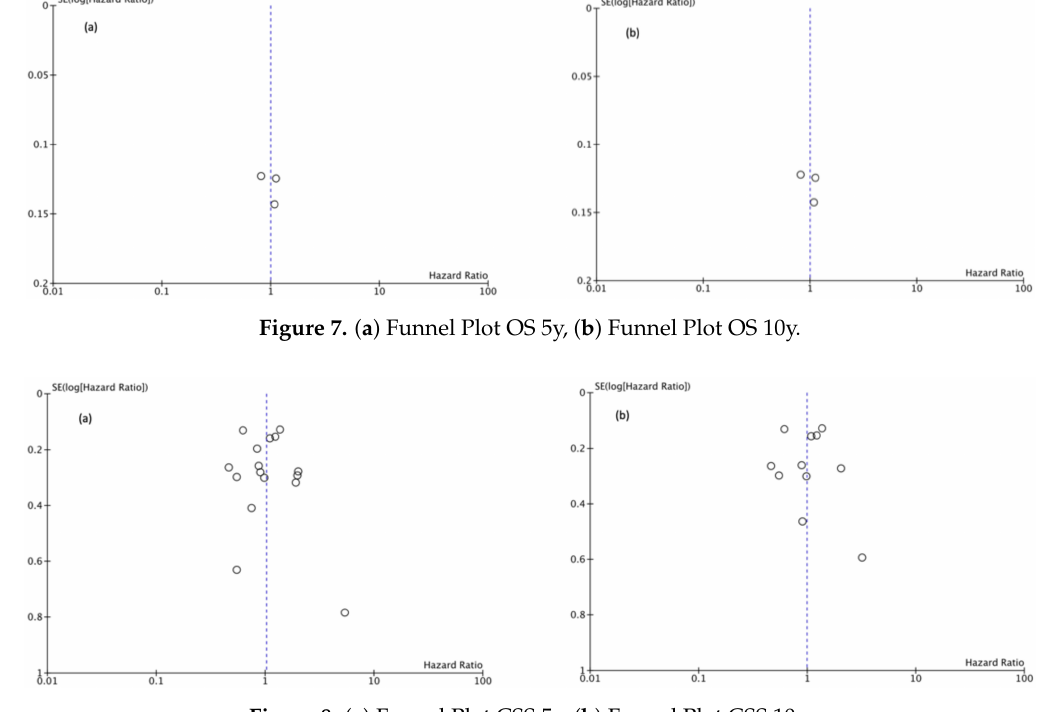
Figure 8. ( a ) Funnel Plot CSS 5y, ( b ) Funnel Plot CSS